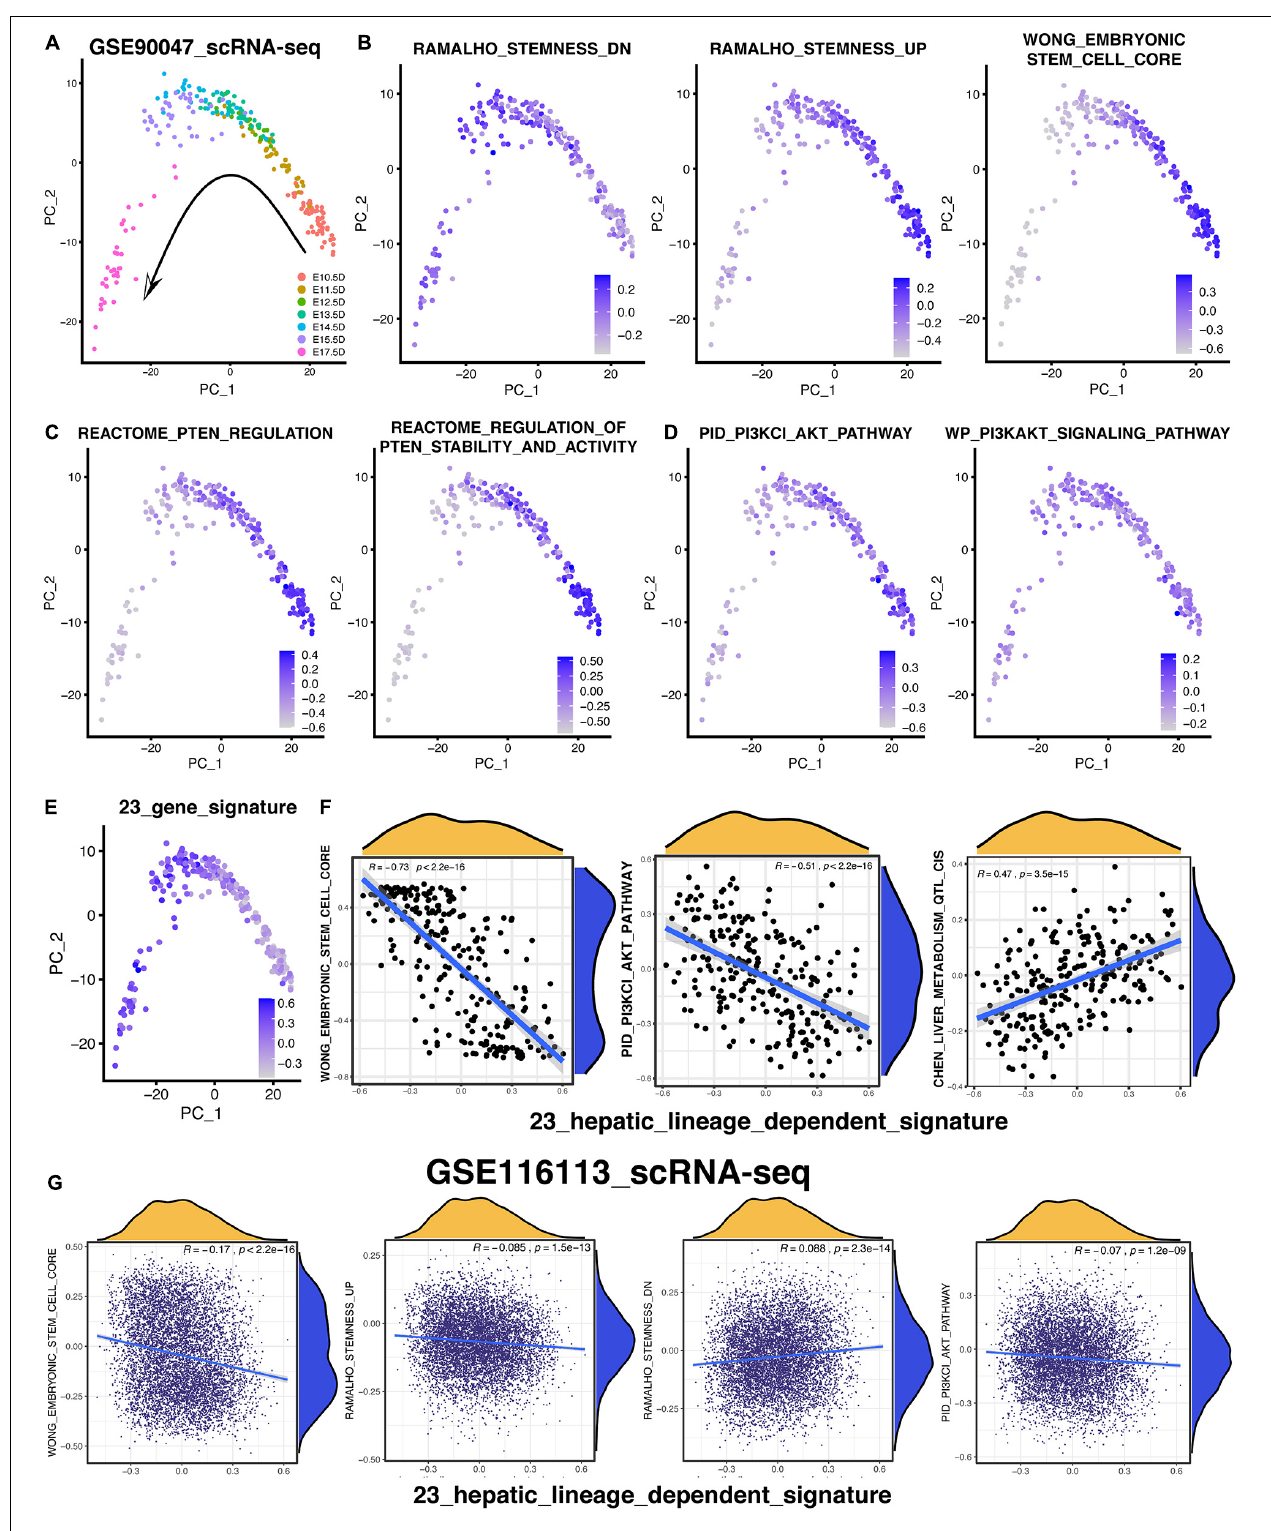
FIGURE 8 | PTEN/PI3K/AKT signaling pathway is lineage-dependent activation following the hepatic maturational trajectory. (A–E) PCA analysis was used to exhibit the lineage trajectory of 251 hepatoblasts/hepatocytes. GSVA analysis was performed to understand various signature patterns of these scRNA-sea data. (F) Correlation analysis of 23-gene signature with others in 251 hepatoblasts/hepatocytes. (G) Correlation analysis of 23-gene signature with others in 7,459 hepLPCs.